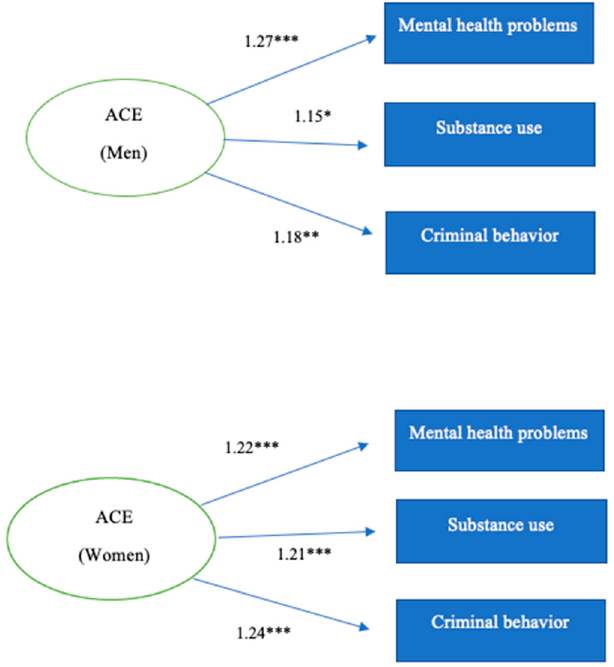
Figure 2. Regression models: impact on mental health, alcohol and/or substance use, and criminal behaviors in men and women. p < 0.0001 *** p < 0.001 ** p < 0.01 *.